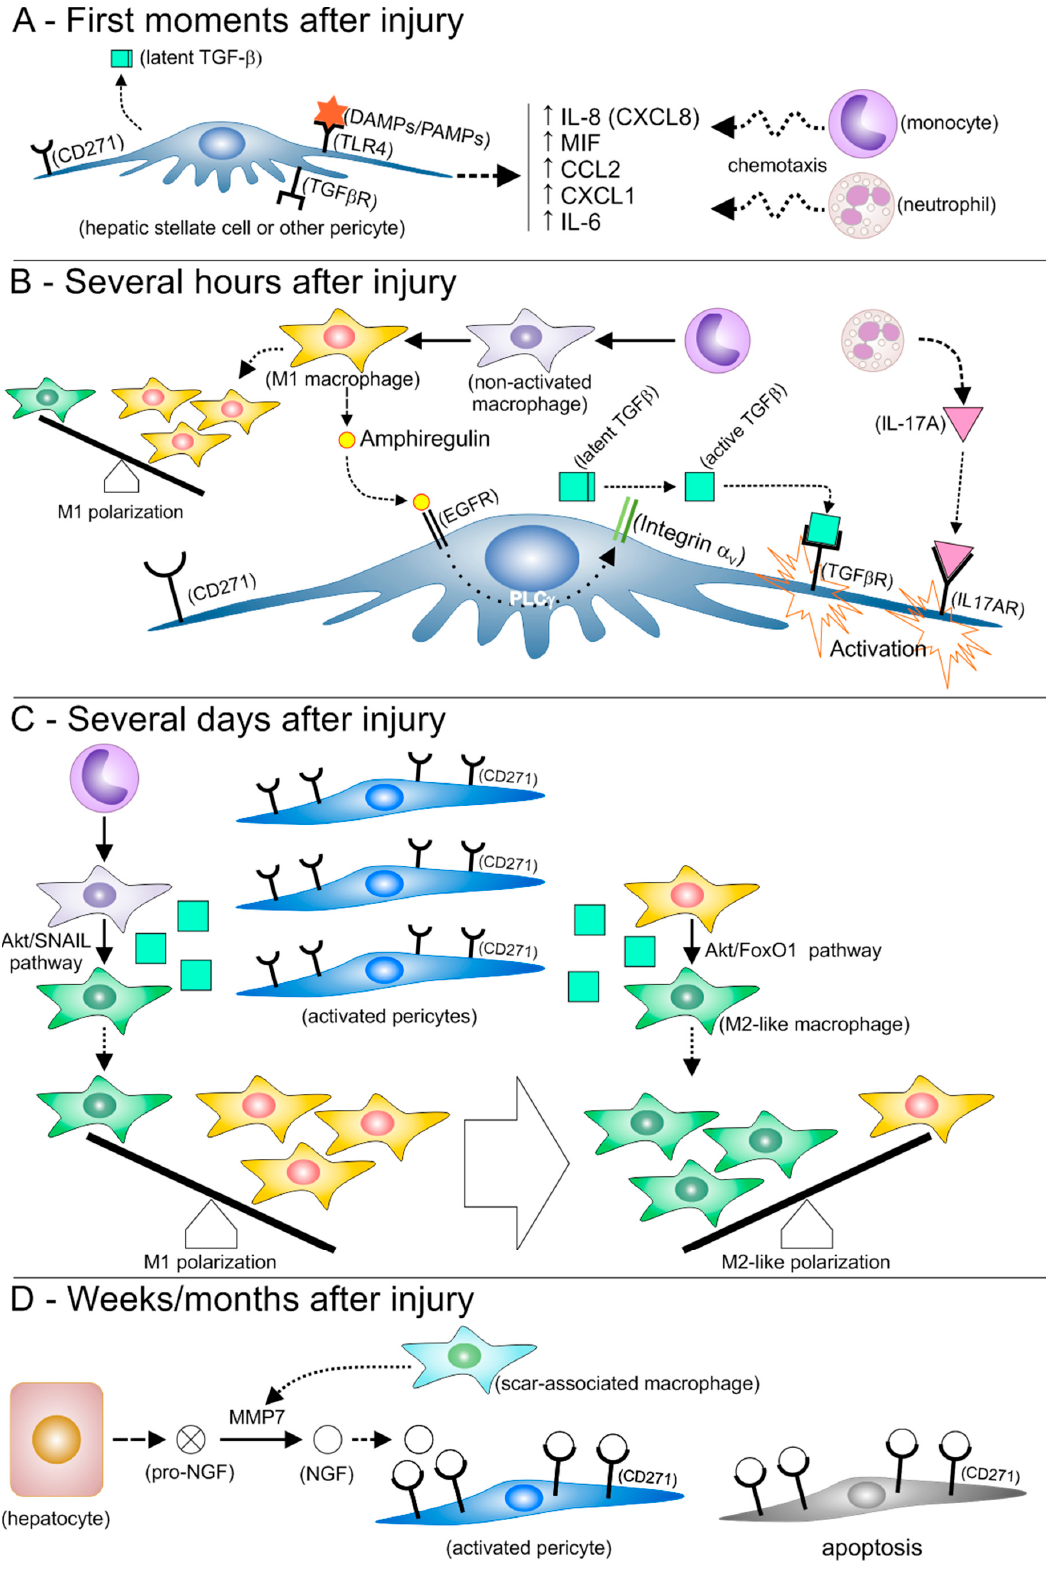
Figure 2. Molecular events mediating the interactions between inflammatory cells and perivascular cells soon after a liver injury event and thereafter. ( A ) Binding of DAMPs or PAMPs to toll-like receptor 4 (TLR4) increases secretion of a number of molecules that are chemotactic to neutrophils